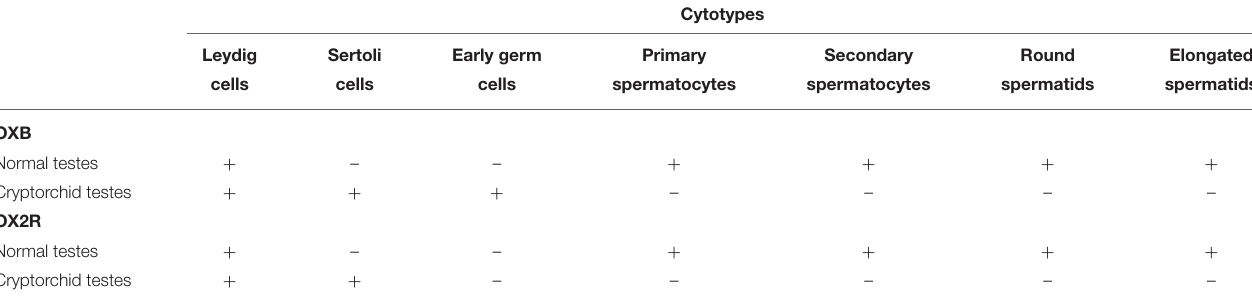
TABLE 2 | Localization of OXB and OX2R in the male gonad of normal and cryptorchid dogs.